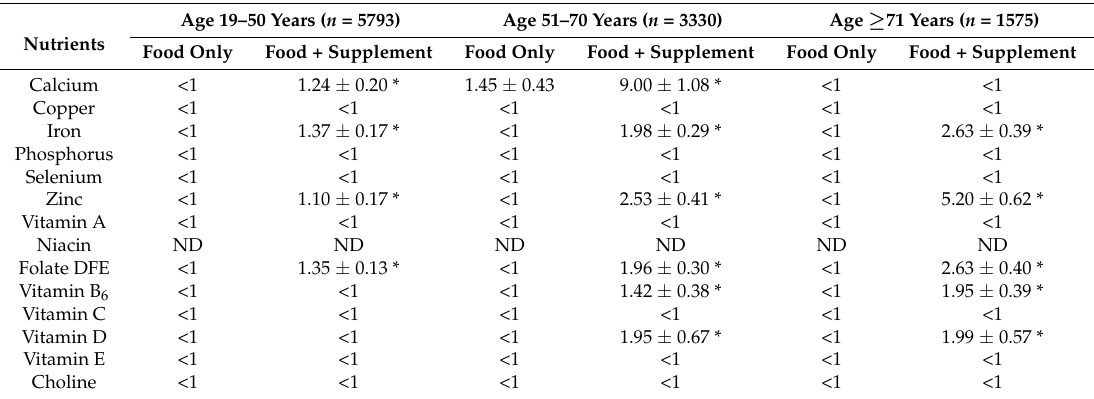
Table 5. Percent adult (19+ years old) population exceeding Tolerable Upper Limit of intake (UL) of nutrients from foods and foods + dietary supplements by age groups. NHANES 2009–2012 gender combined